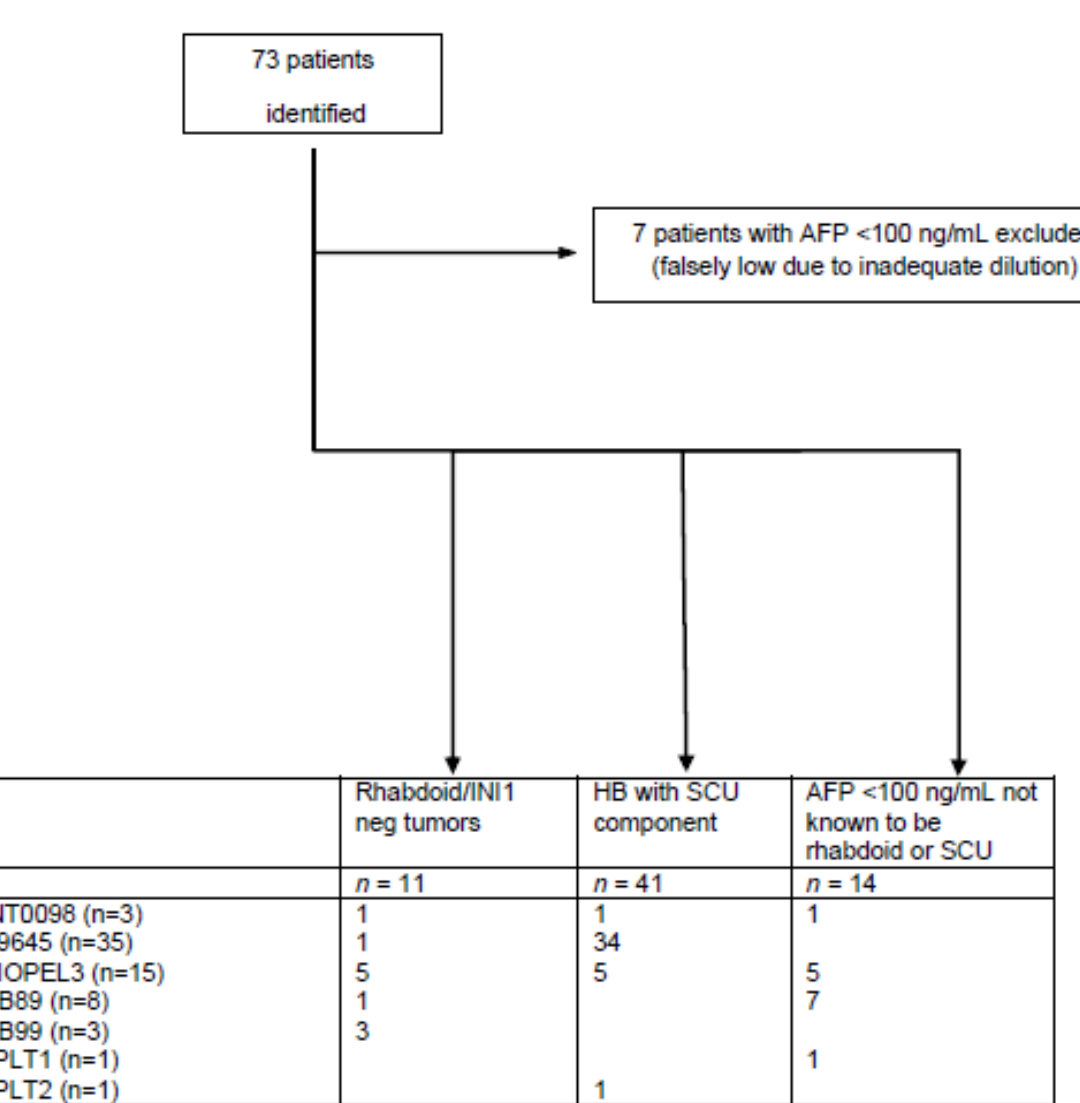
Figure 1. CONSORT statement to identify patients treated for hepatoblastoma who had alpha- fetoprotein levels below 100 ng/mL or who were historically diagnosed as small cell undifferentiated hepatoblastoma. Retrospective CHIC consensus pathology review: 20 patients; Previously known to have loss of SMARCB1 expression [7]: 1 patient. Histological slides available for review by CHIC pathologist DLT: 16 patients. Trial retrospective review: 4 patients. Trial pathology reports review: 25 patients. AFP, alpha-fetoprotein; HB, hepatoblastoma; SCU, small cell